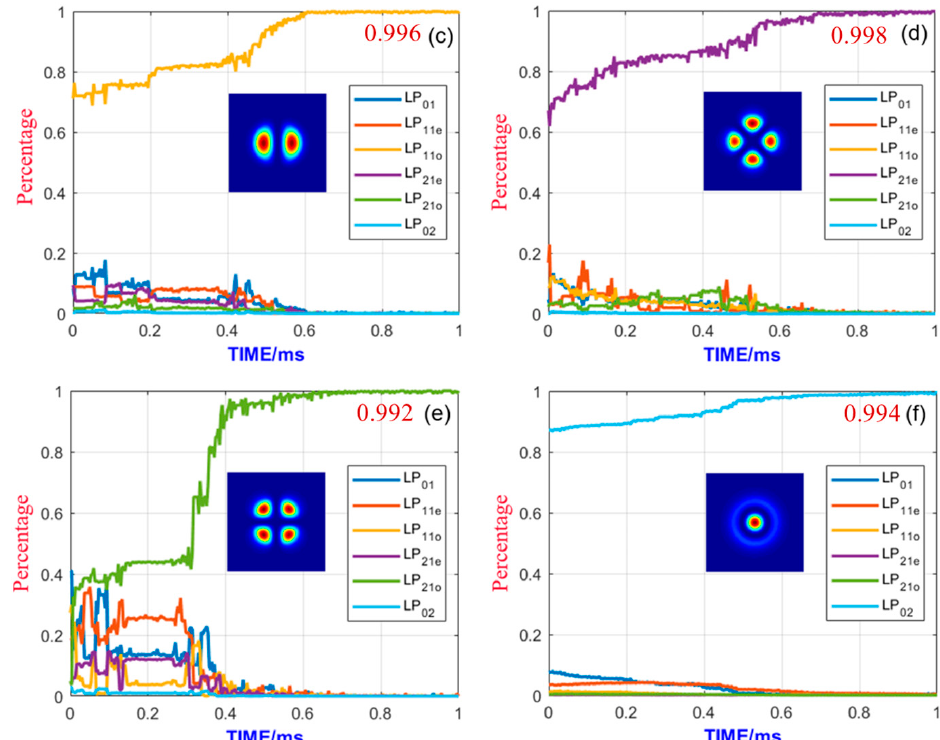
Figure 5. Mode content evolution of 6 × 1 photonic lantern initialized by the reverse of the transmission matrix, where the desired mode is chosen as the evaluation function. ( a ) LP 01 , ( b ) LP 11e , ( c ) LP 11o , ( d ) LP 21e , ( e ) LP 21o , and ( f ) LP 02 . The time window is set to 1 ms as the curves mostly stabilize.